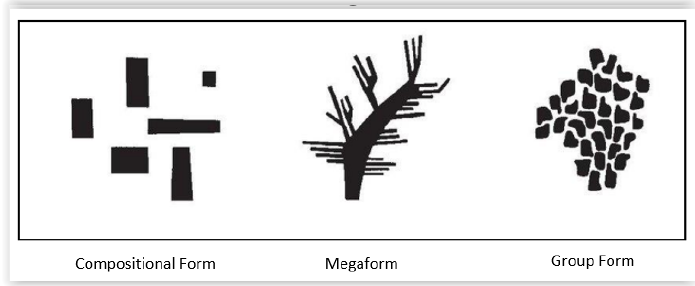
Figure 6 Fumihiko Maki's collective linkage forms (Maki,